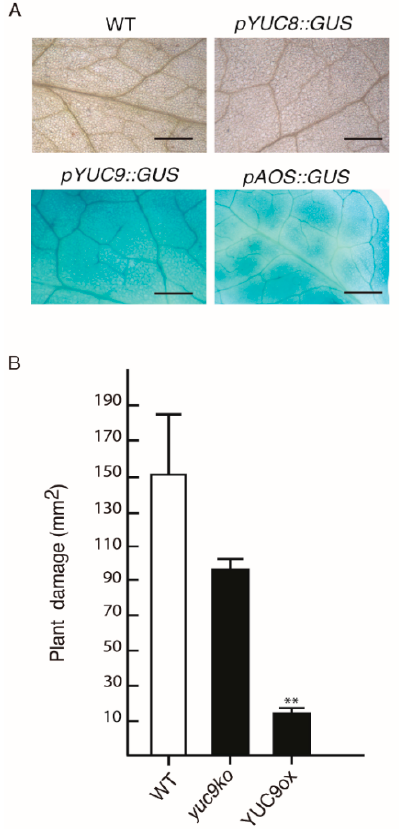
Figure 6. YUC9 activation and plant damage assay after four days of spider mite ( Tetranychus urticae ) herbivory. ( A ) Histochemical GUS staining of leaves from wild-type Arabidopsis , pYUC8::GUS , pYUC9::GUS and pAOS::GUS plants, using 20 females from T. urticae per plant (n = 5). Scale bar = 50 µm. ( B ) Quantification of the total plant damage area (expressed in mm 2 ) in WT, yuc9ko and YUC9ox mutant lines. Represented are means ± SE (n = 5). Student’s t -test: ** p < 0.01.